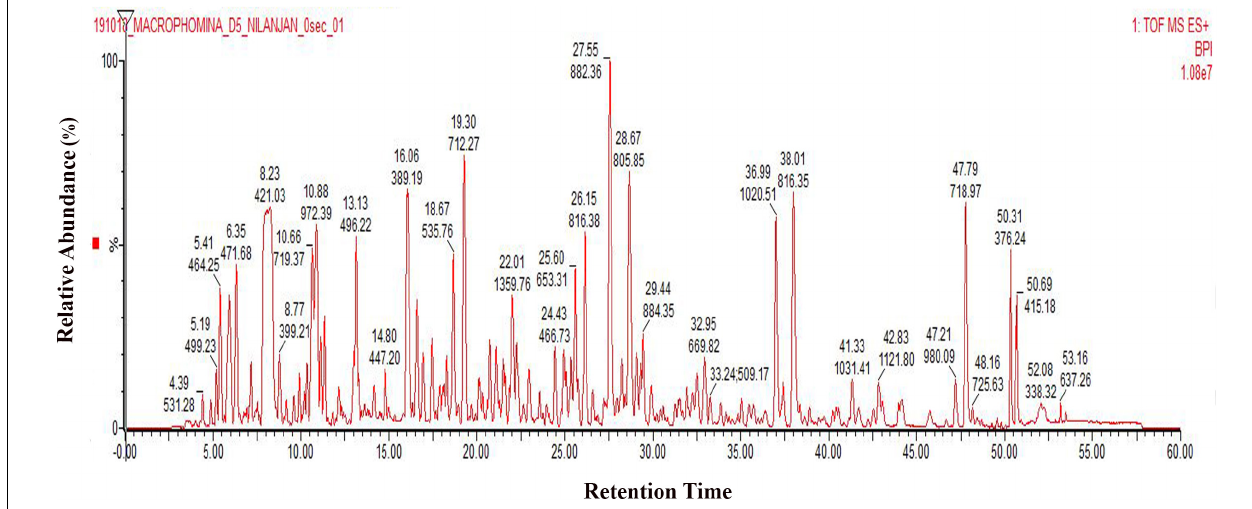
FIGURE 1 | LC-ESI-MS/MS chromatogram of M. phaseolina secretome collected 5 days after inoculation. Chromatogram of secretome was generated using 1 mg/mL protein run in Waters-Xevo-G2-X’S-Q-TOF-TOF. The total MS E scan time was 60 min in which 0–5 min was the equilibration time, and then 5–50 min was the elution of peptides from the column, and 50–60 min was the washing of the